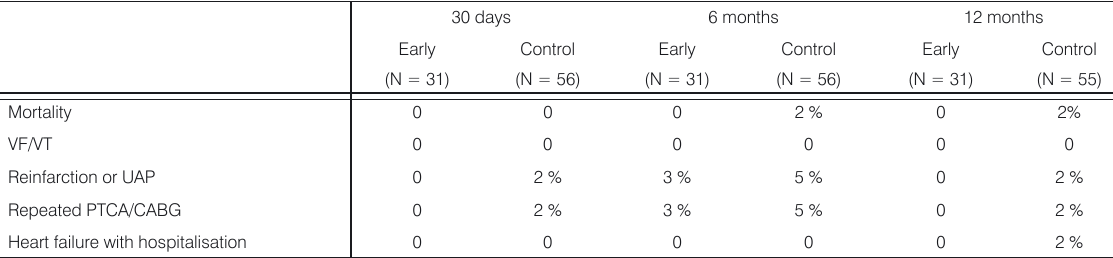
Figure 1. Kaplan-Meier analysis of composite event-free survival for early discharged patients and patients with conventional duration of hospitalization. Composite end point included: death, reinfarction or unstable angina pectoris, need for repeated revascularisation, and heart failure necessitating